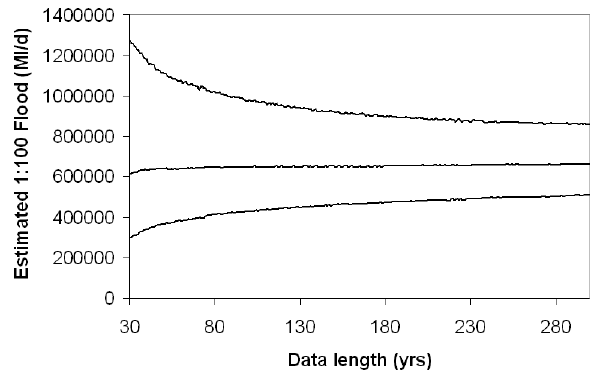
Figure 5. Median and 90% uncertainty quantiles of estimated 1% AEP from randomly sampled Monte Carlo replicates. 4